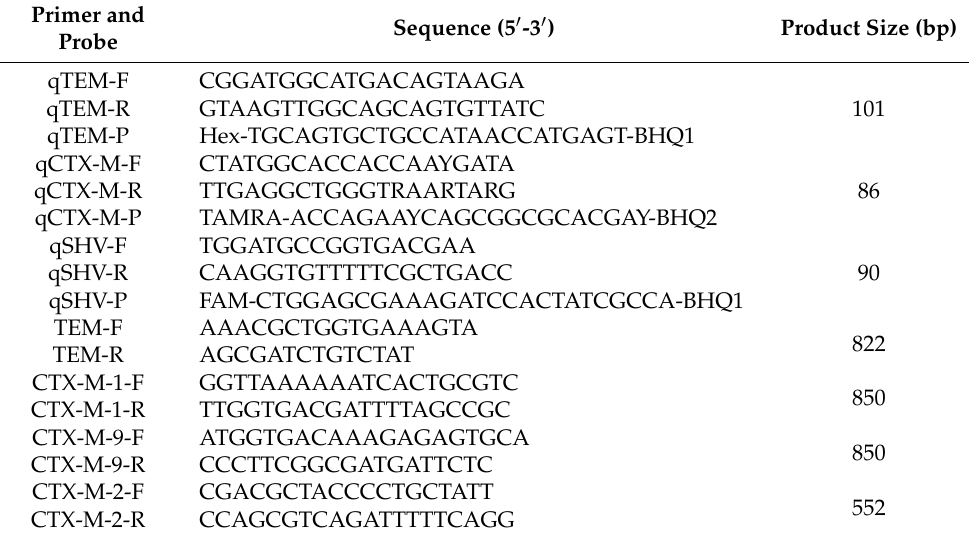
Table 1. Primer sequences used for detecting bla CTX-M , bla SHV , and bla TEM genes. Primer